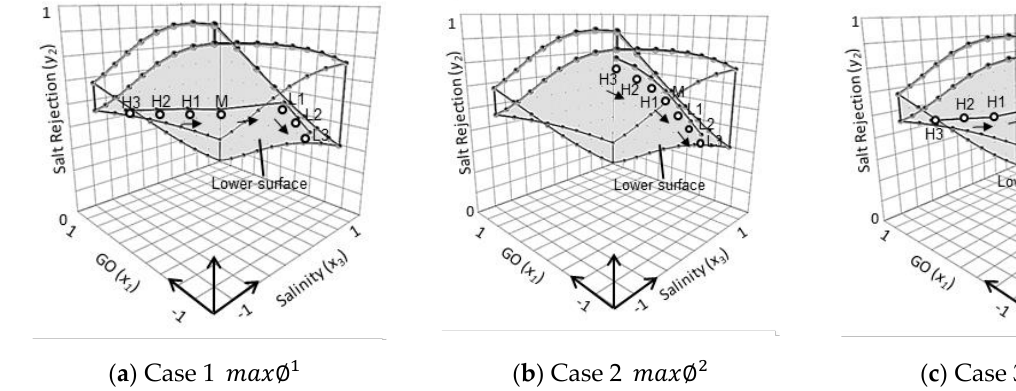
Figure 9. Optimized paths for salt rejection output ( y 2 ).